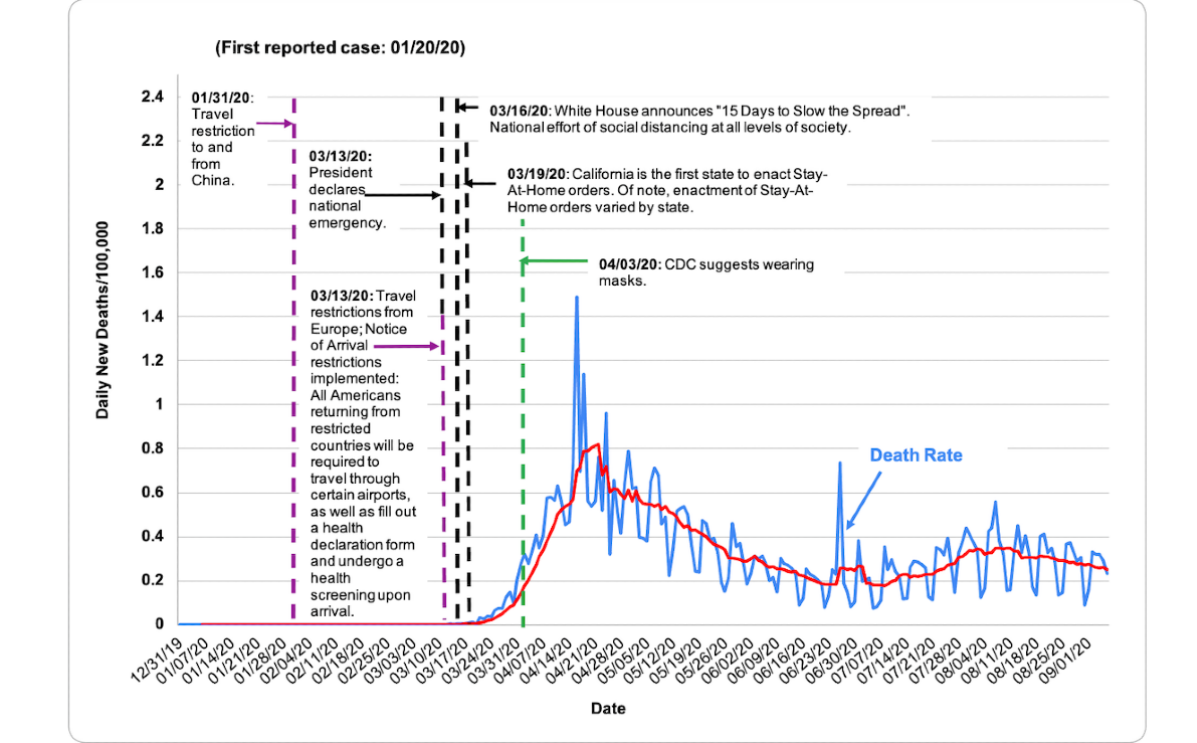
Figure 5. Daily new deaths per 100,000 people for the United States from December 31, 2019, to September 6,